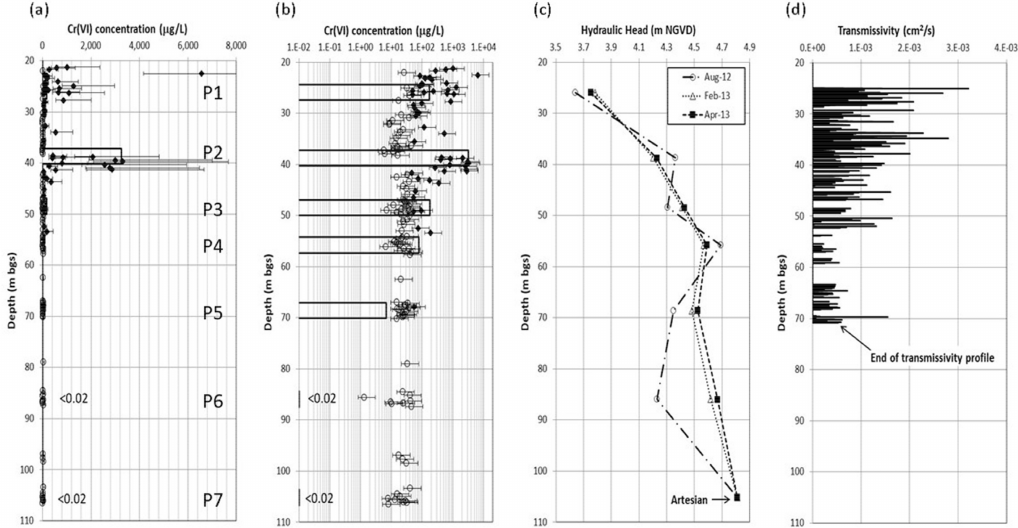
Figure 6. (a) Results of Cr ( VI ) rock core analyses for samples collected in April-May 2012 and groundwater Cr ( VI ) from MLS sampling (MLS port intervals shown as P1 to P7) in August 2012 plotted on ( a ) linear and ( b ) logarithmic scales. Solid symbols represent positive detections while open symbols represent values that cannot be differentiated from background [32]. Additionally, shown are ( c ) hydraulic head profiles from the MLS, and ( d ) transmissivity profile, which was terminated at ~71 m bgs when the liner descent rate dropped below the testing threshold [35]. Adapted from Chemical Geology, 419, Zhao et al., Determination of hexavalent chromium concentrations in matrix porewater from a contaminated aquifer in fractured sedimentary bedrock, p. 146, Copyright (2015), with permission from Elsevier.